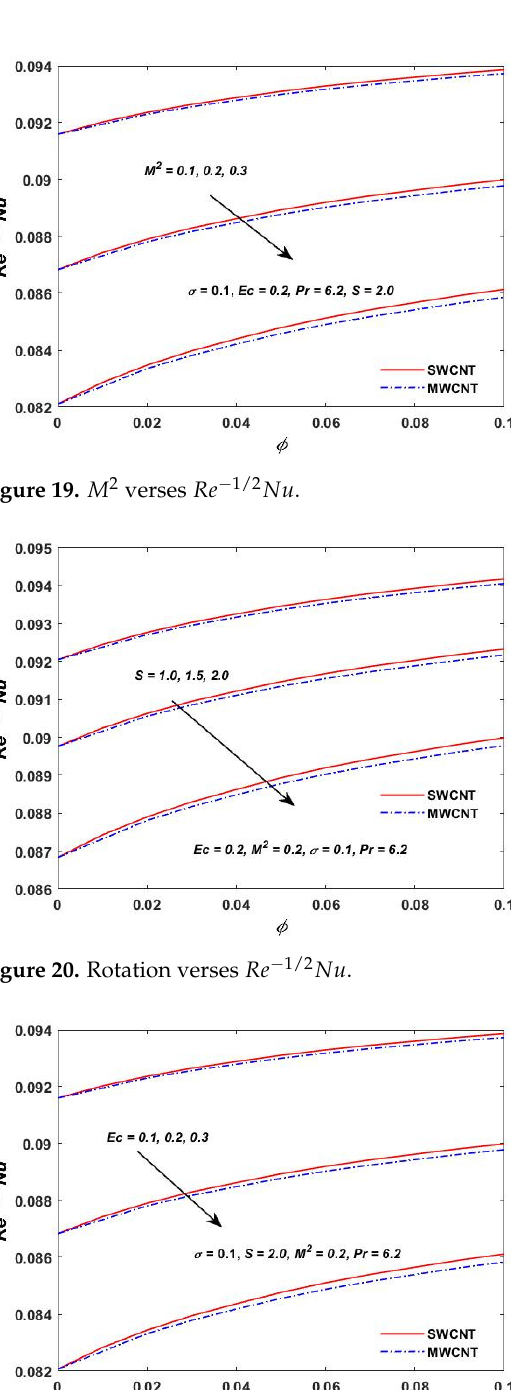
Figure 18. Prandtl verses 𝑅𝑒 (cid:2879)(cid:2869)/(cid:2870) 𝑁𝑢.